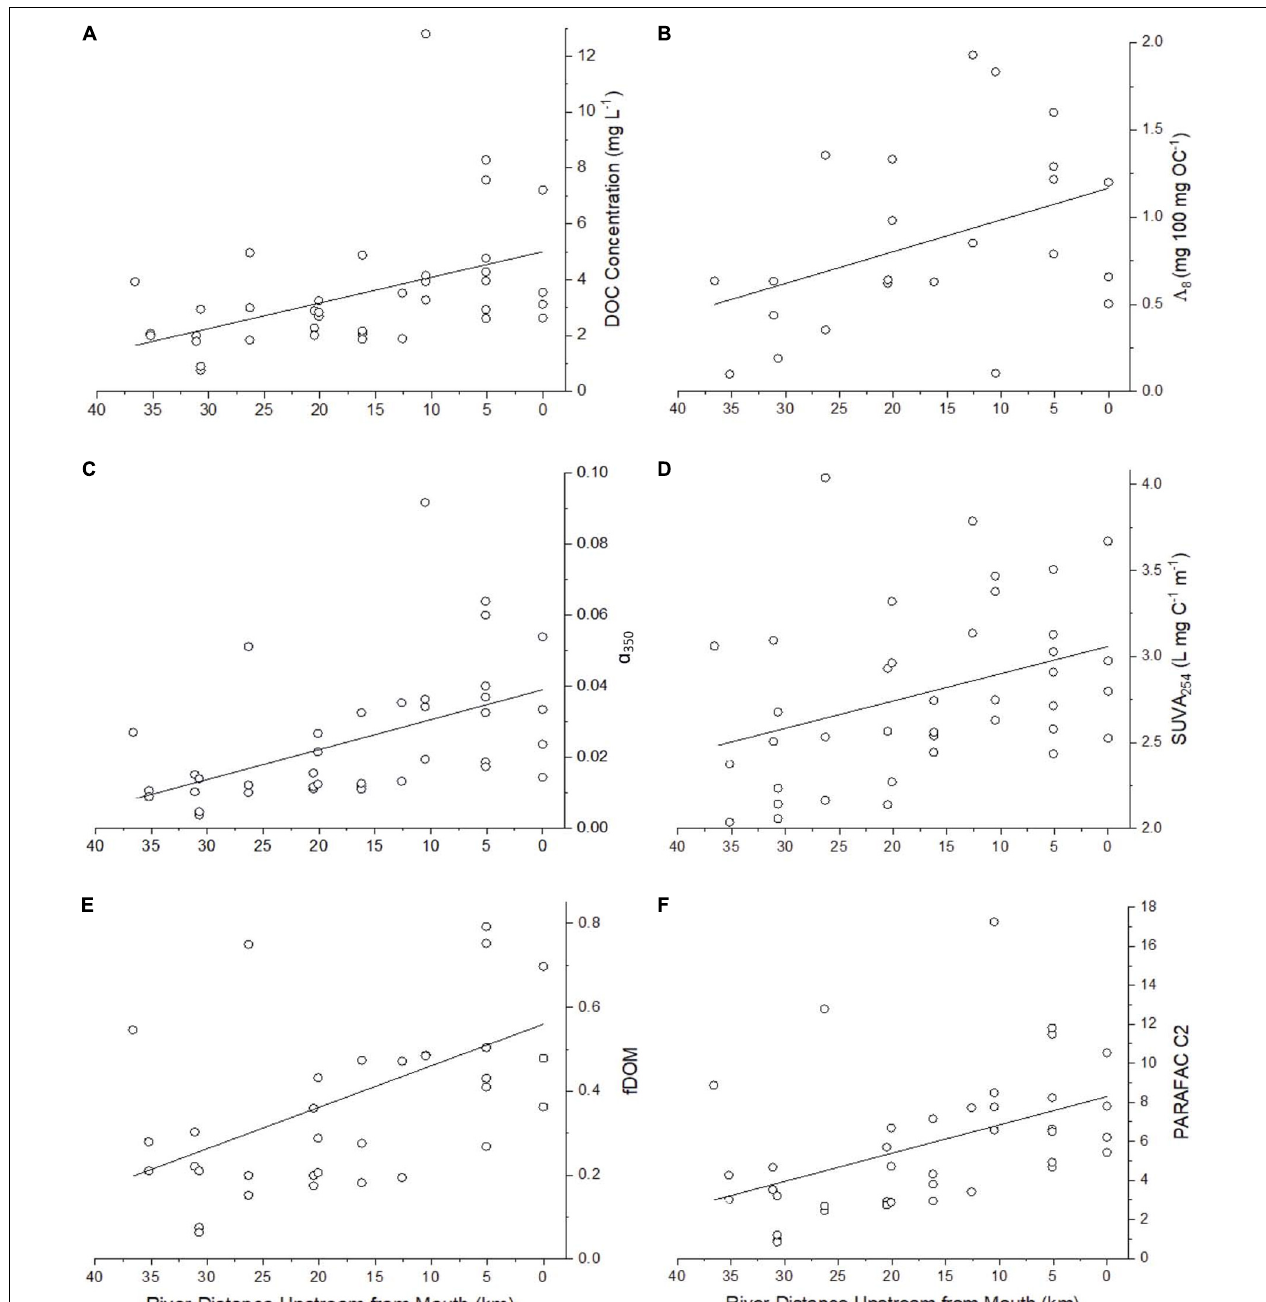
FIGURE 3 | Select parameters showing incremental increases and decreases longitudinally along the Willow Slough Watershed including (A) DOC ( n = 39, ρ = − 0.56, p < 0.001), (B) Lignin (cid:51) 8 ( n = 23, ρ = − 0.42, p < 0.05) (C) α 350 ( n = 39, ρ = − 0.64, p < 0.001) which correlates strongly with lignin (cid:54) 8 ( Figure 3B ), (D) SUVA 254 ( n = 39, ρ = − 0.41, p < 0.05), (E) fDOM ( n = 34, ρ = − 0.50, p < 0.05), and (F) PARAFAC C2 ( n = 39, ρ = − 0.54, p < 0.001). See Table 4 for a list of significance p values and Spearman rank correlation coefficients ( ρ ) for many additional parameters that also showed incremental increases and decreases along the watershed.